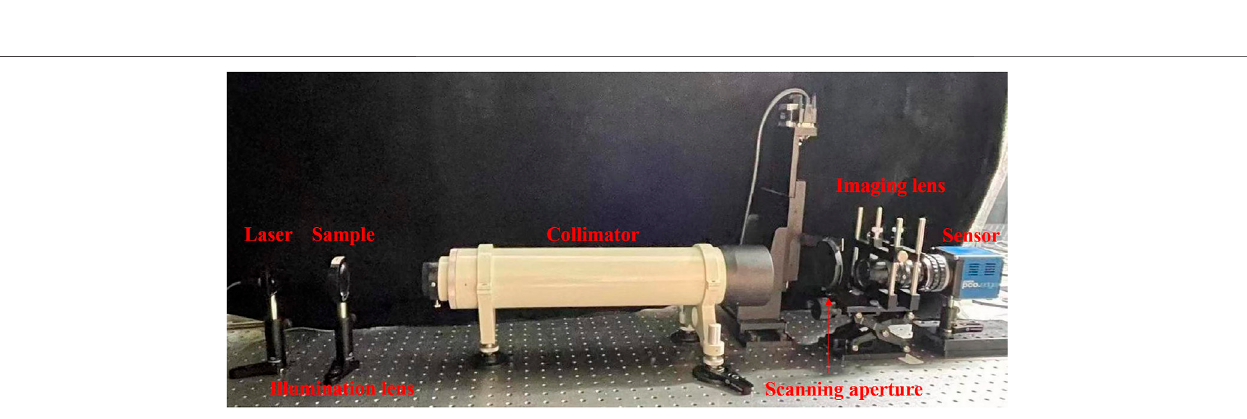
Frontiers in Physics |